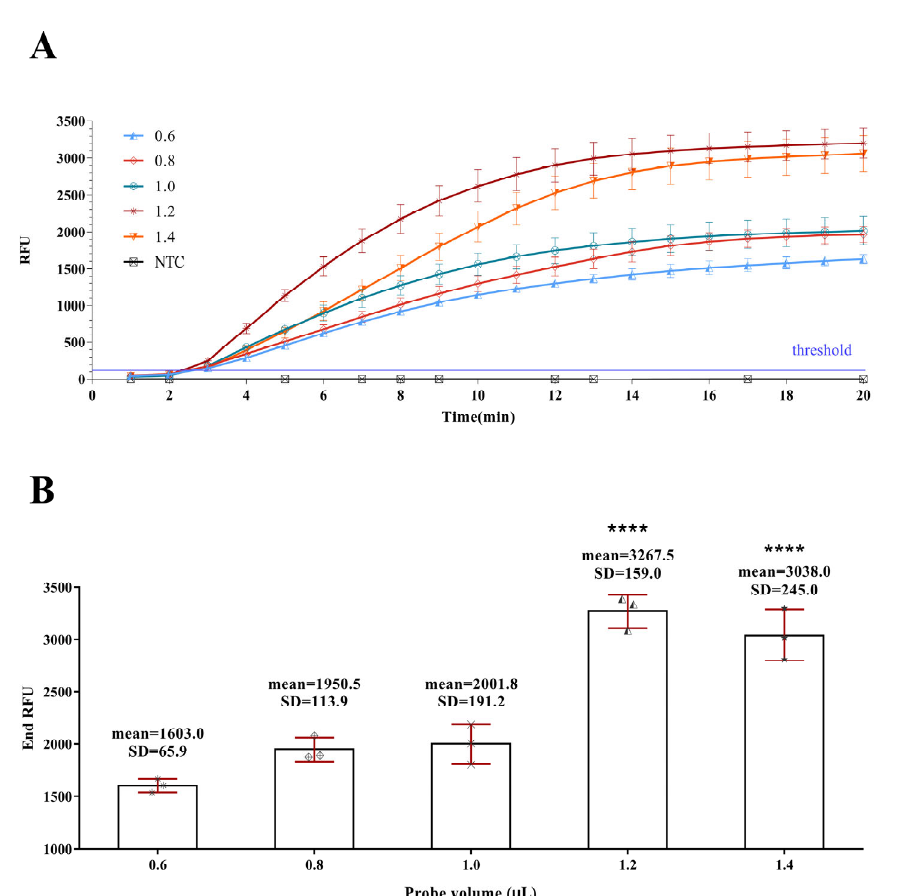
Figure 3. Optimization of the probe concentration. ( A ) Amplification curves of the positive plasmid samples corresponding to the different probe concentrations used. ( B ) Threshold times of the positive plasmid samples corresponding to the different probe concentrations used SD: standard devi ‐ ation. Compared with each group, significant differences were indicated with asterisks: ****, p < 0.0001.